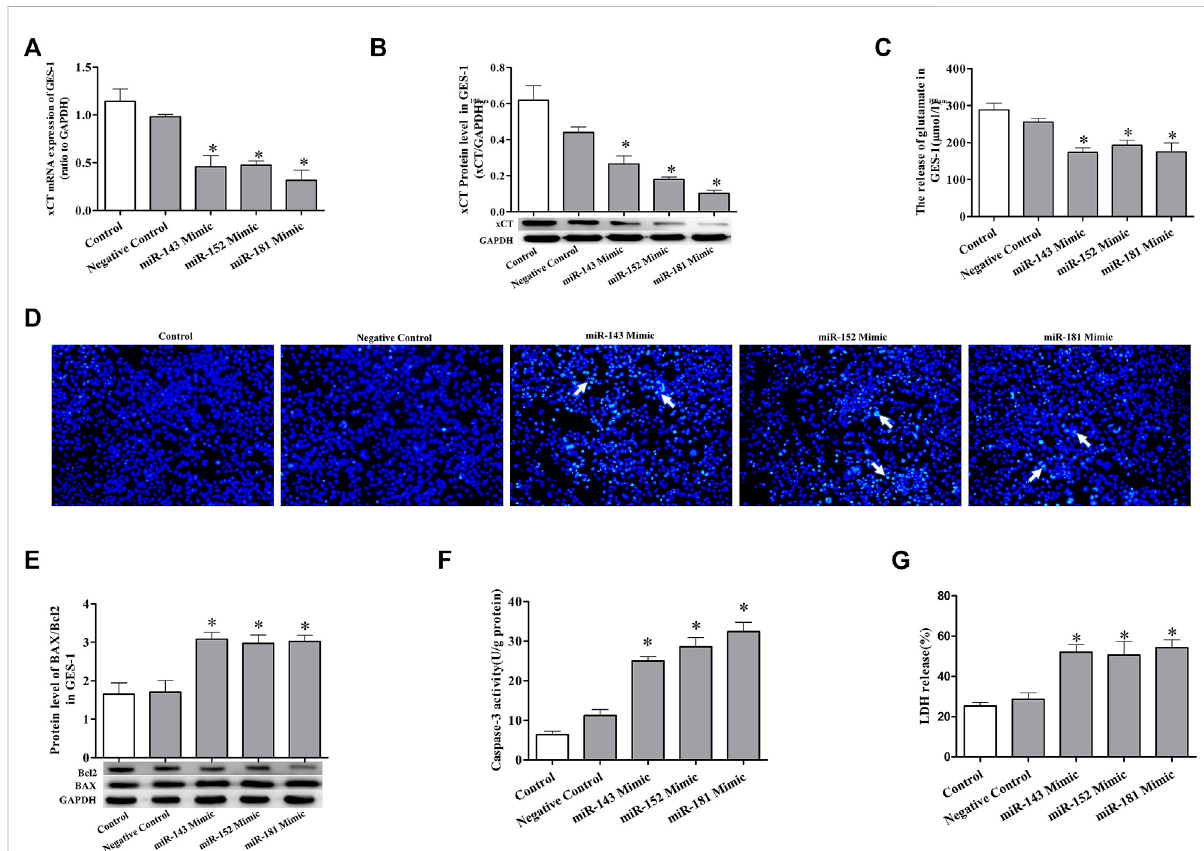
FIGURE 4 miRNA mimics suppress theexpression of xCT and induce cell injury. (A) xCT mRNA level in GES-1 cells. (B) The protein expressionlevel of xCT in GES-1 cells. (C) The concentration of released glutamate in GES-1 cells. (D) Detection of apoptosis (×100). (E) The ratio of pro-apoptotic protein BAX to anti-apoptotic protein Bcl-2 used to detect apoptosis. (F) Caspase-3 activity. (G) LDH release. Data are expressed as mean ± standard error ( n = 3). * p < 0.05 vs. Negative